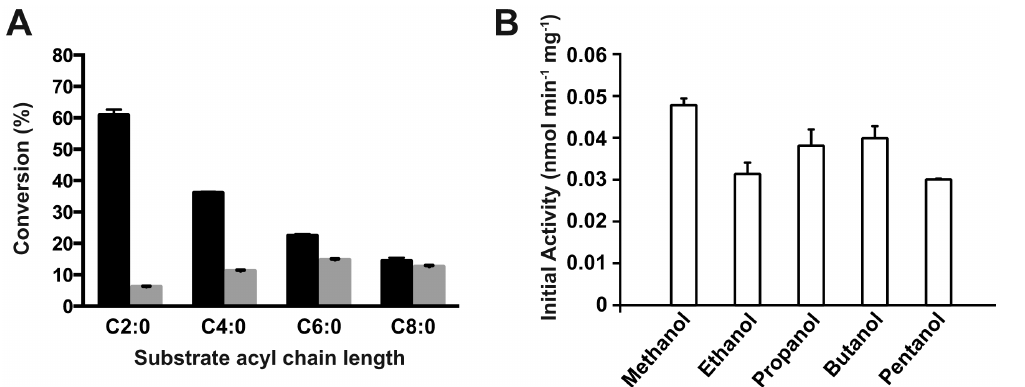
Figure 3. Conversion rates of LipIAF5-2 WCB transesterification and esterification toward acyl donors and acceptors. A) The full bars representtheconversionoftriglyceridesubstratesandthe shaded graybarstheconversionofequivalentfreefattyacids(FFA).Thesubstratesemployed are glyceryl triacetate and acetic acid (C2:0), glyceryl tributyrate and tributyric acid (C4:0), glyceryl trihexanoate and hexanoic acid (C6:0) and glyceryl trioctanoate and octanoic acid (C8:0). The results are expressed as the molar conversion of 1 mmol of each substrate after 6 hours of incubation at 40 u C with 4 molar equivalents of methanol and 10 mg of LipIAF5-2 WCB. B) Impact of acyl acceptors on transesterification by LipIAF5-2 WCB. Transesterification of 1 mmol of glyceryl tributyrate was done using 4 molar equivalents of each primary alcohols for 3 hours at 40 u C using 10 mg of LipIAF5-2 WCB and 10% (w/w) water. Results are averaged over two independent experiments performed in triplicate.